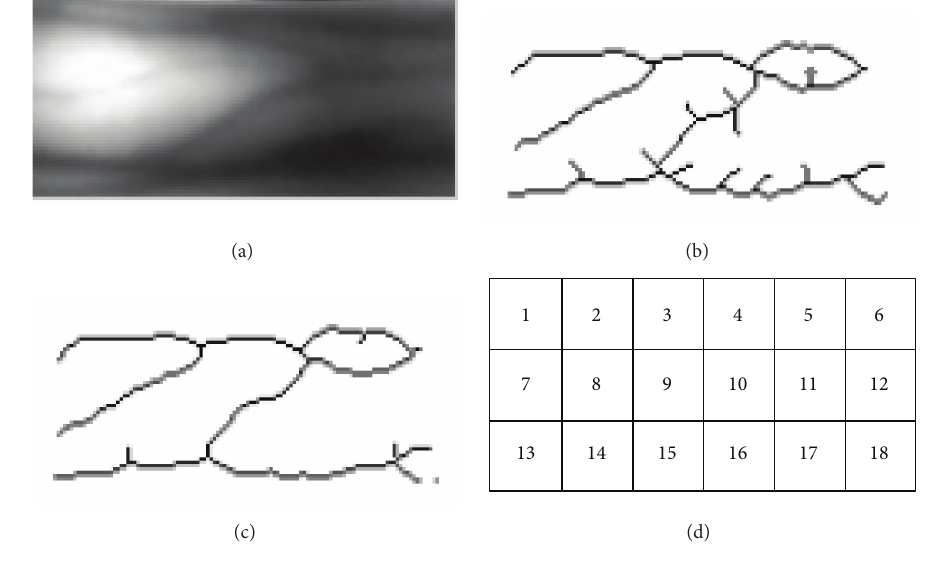
Figure 8: Skeleton images using morphology thinning algorithm.